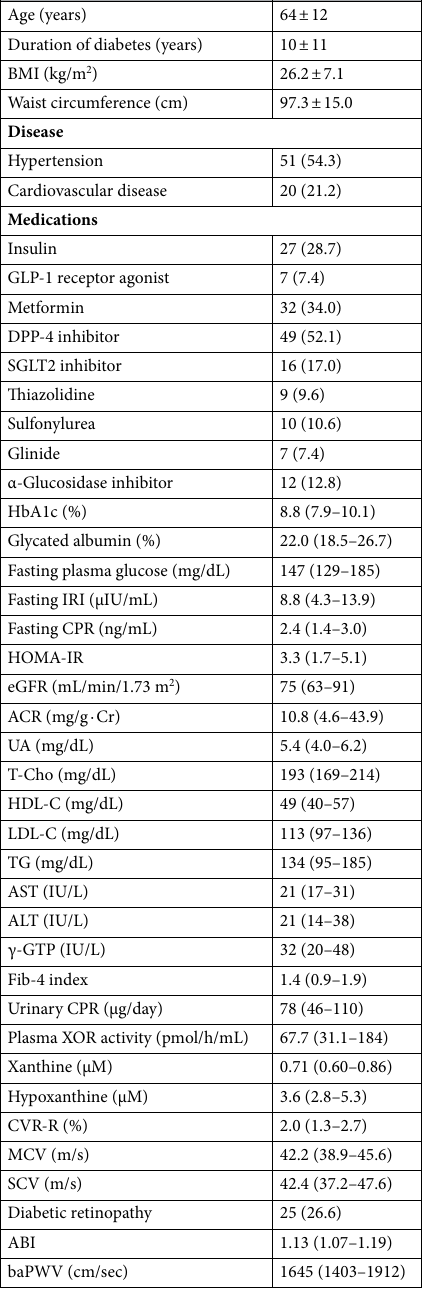
Table 1. Clinical characteristics of the study patients. Data are presented as means ± standard deviation, medians (interquartile range) or number (%). BMI body mass index, HbA1c glycosylated haemoglobin,